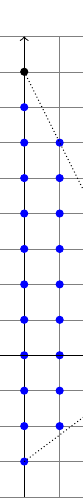
Figure 5. The Newton polygon for ‘ = N , drawn for N = 4 and k = 2 N = 8